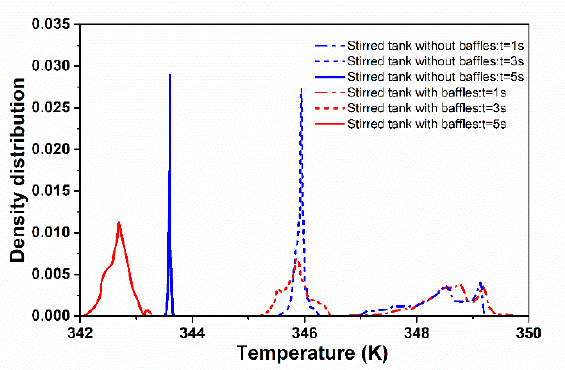
Figure 23. Comparison of the temperature distribution of the stirred tanks with and without baffles at time is 1 s, 2 s and 3 s.